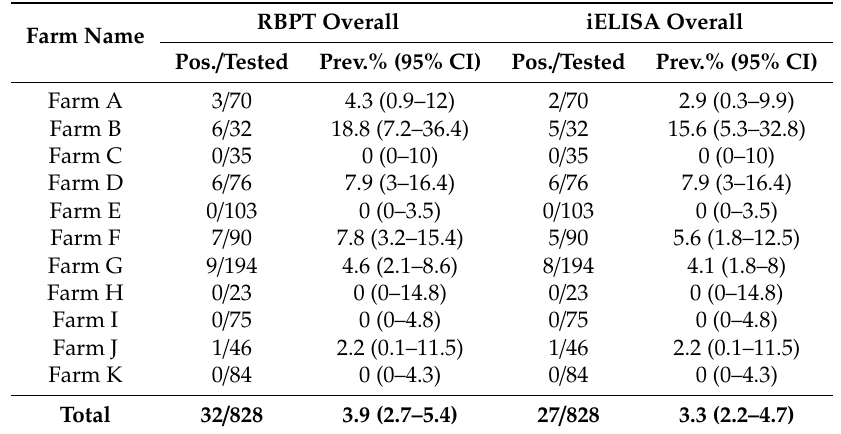
Table 2. Overall Seroprevalence of brucellosis in cattle and bu ff aloes sampled from di ff erent farms.